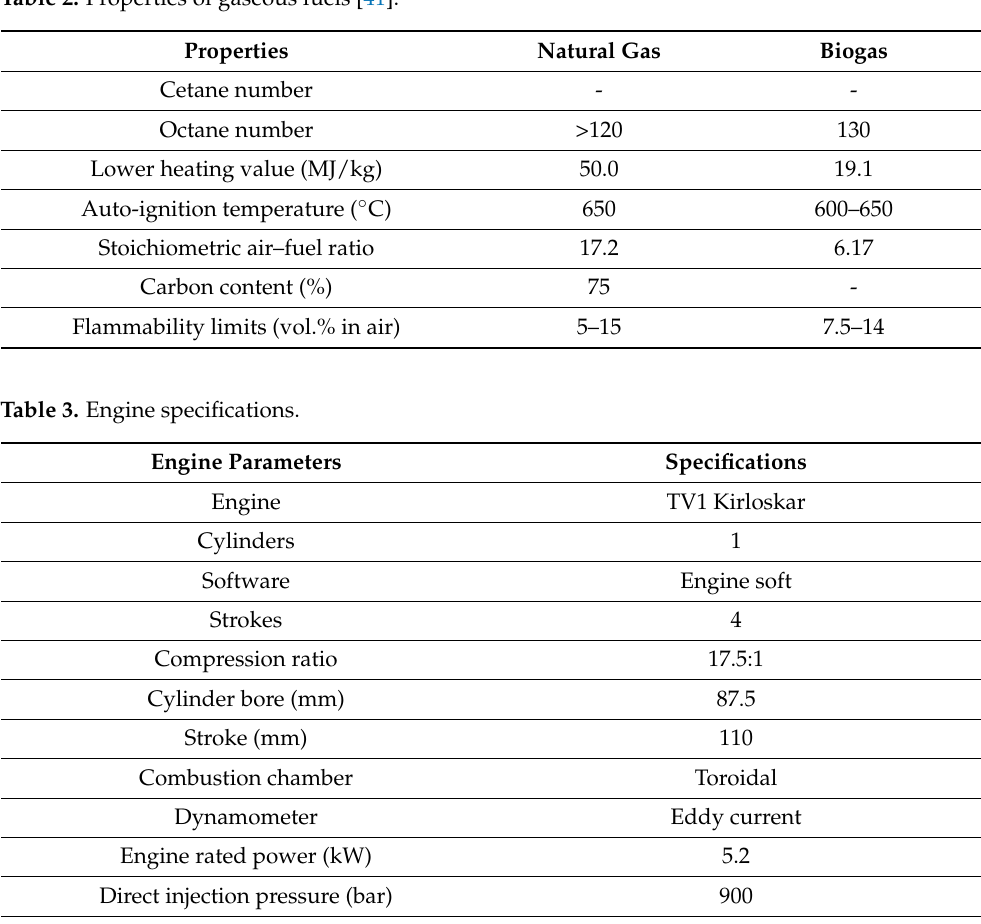
Table 2. Properties of gaseous fuels [41].